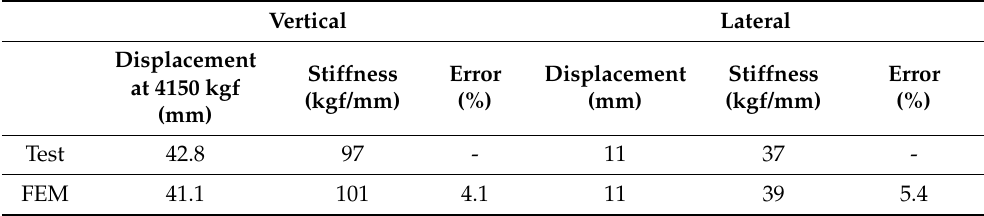
Table 5. Comparison of stiffness of tires from the experiment and the